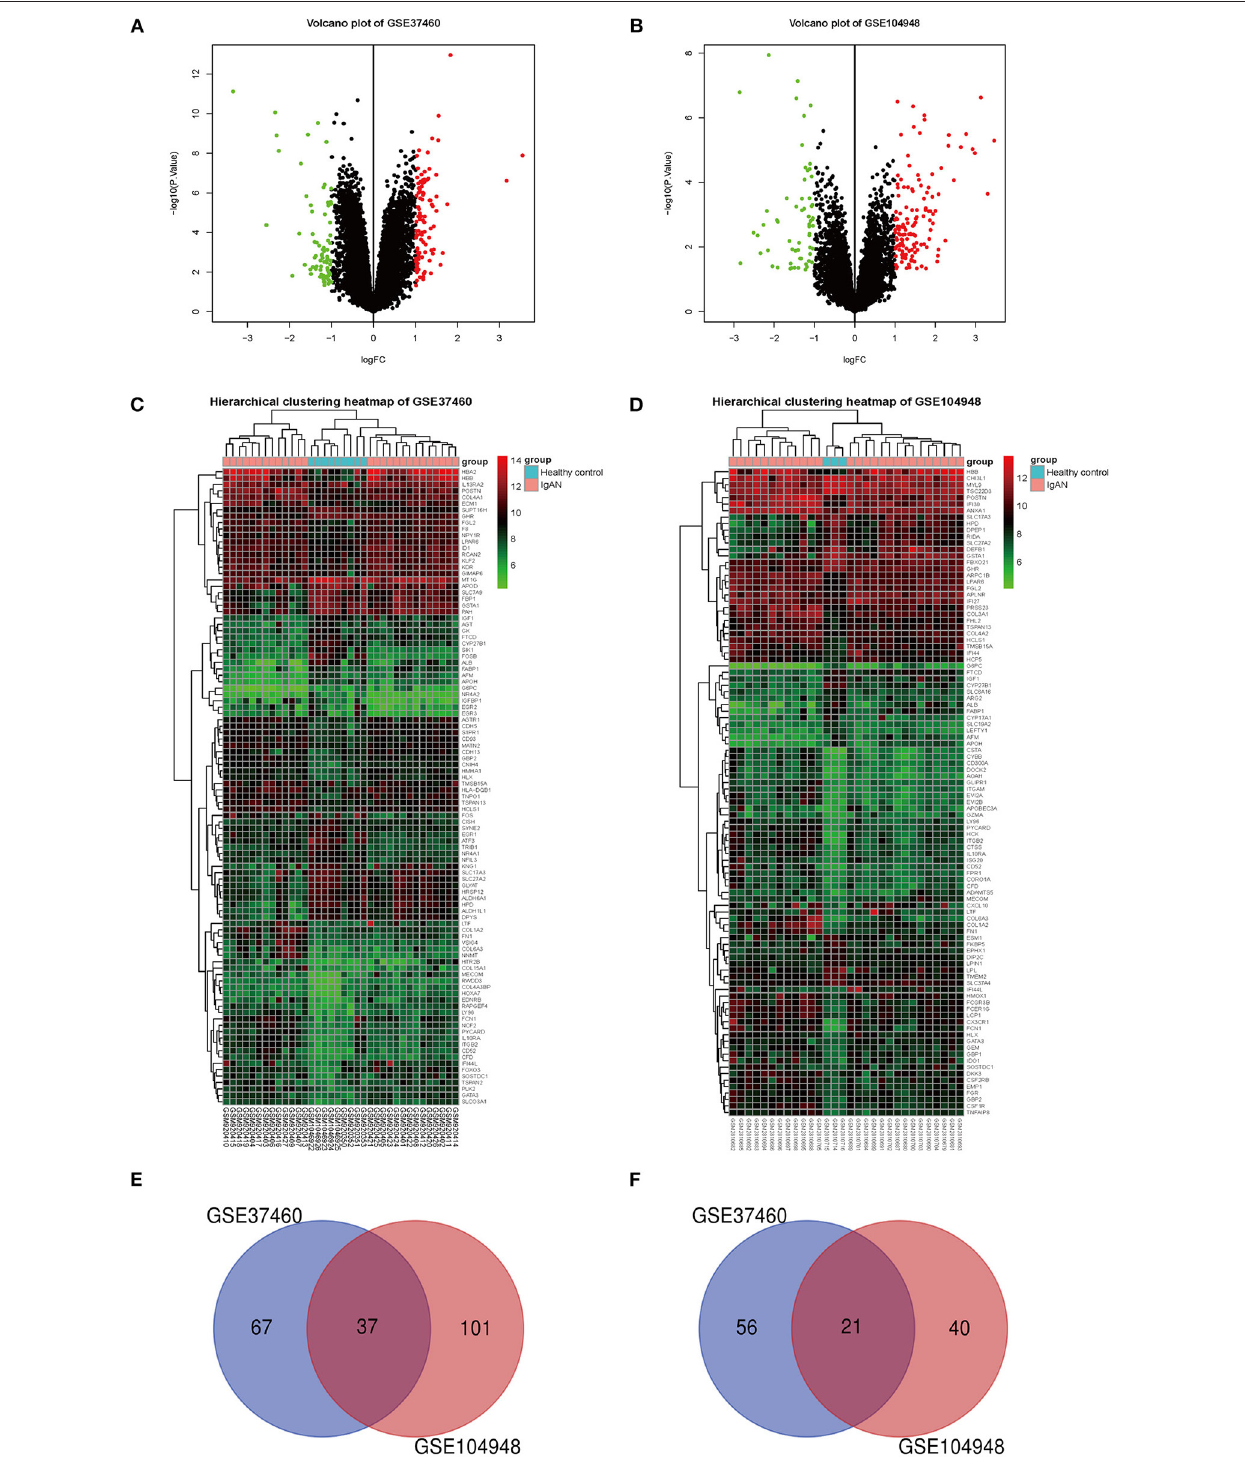
FIGURE 2 | DEG screening and identification of overlapping DEGs. (A,B) Volcano plot of DEGs in the GSE37460 ( n = 181) (A) and GSE104948 ( n = 199) (B) datasets. Red and green points represent upregulated and downregulated genes, respectively, based on |fold change (FC)| ≥ 1.0 and adjusted P < 0.05. The black points represent genes with no significant difference. (C,D) Hierarchical clustering heatmap of the top 100 DEGs of the GSE37460 (C) and GSE104948 (D) datasets based on |FC| ≥ 1.0 and adjusted P < 0.05. The Venn diagram shows overlapping DEGs of GSE37460 and GSE104948. (E,F) The 37 upregulated (E) and 21 downregulated (F) overlapping DEGs in the two